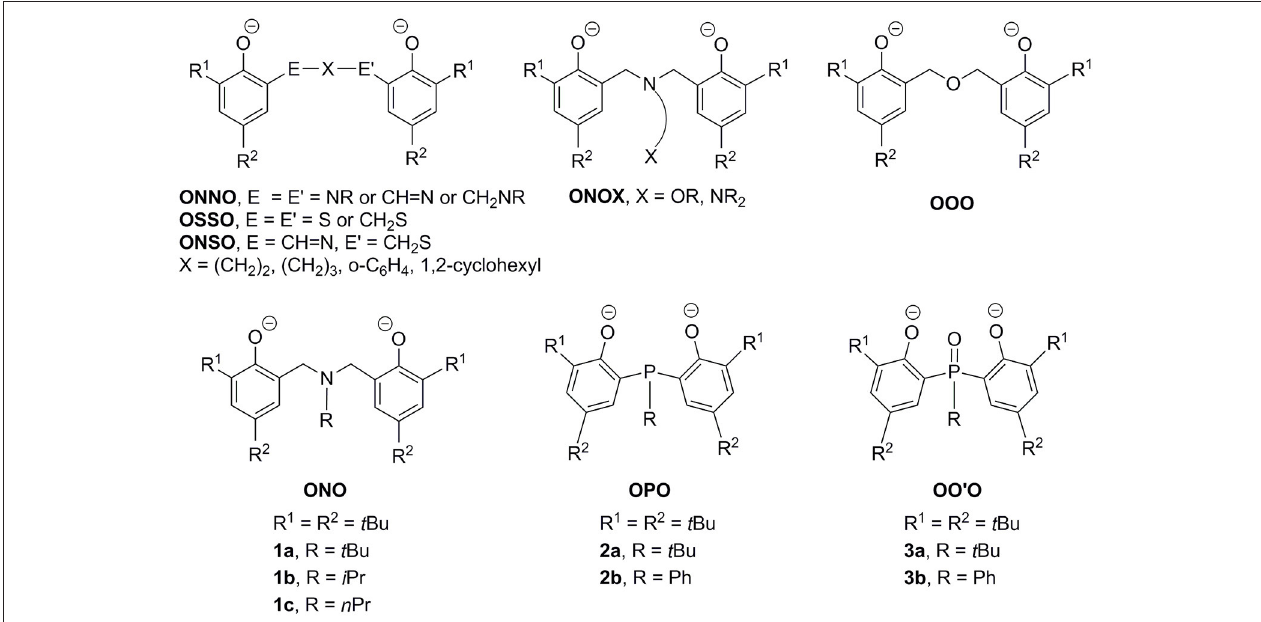
FIGURE 1 | Representative examples of chelating biphenolate